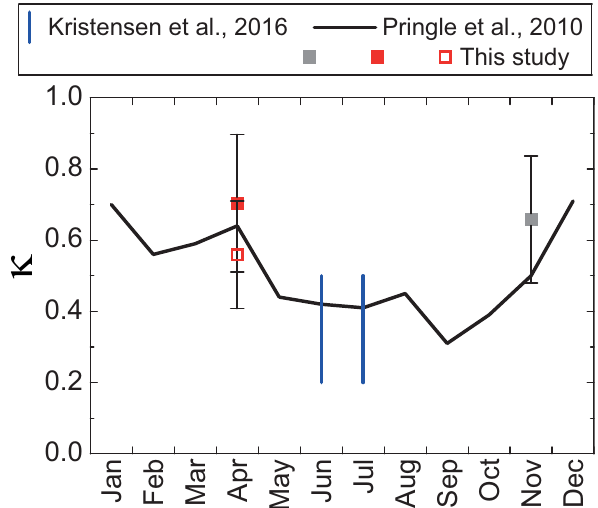
Figure 2. κ values derived at different supersaturations for Novem- ber 2010 and April 2011 (red open squares represent the time from DOY 103 to 107 when dust was observed). Error bars represent the standard deviation resulting from averaging all κ values obtained at the respective supersaturations.